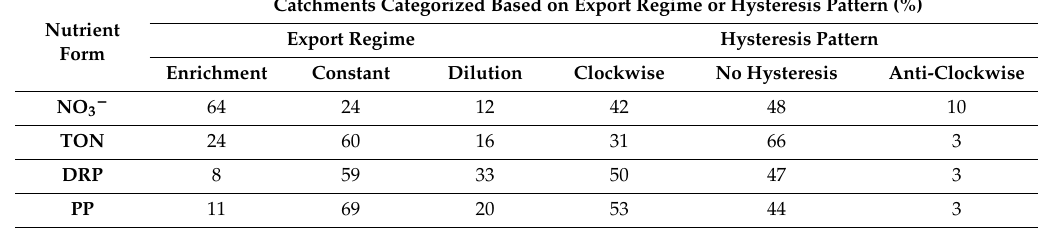
Table 2. Results on the percentage of mini-catchments in three Nordic countries: Denmark, Sweden, and Finland, considering export regime (enrichment, constant, and dilution) and hysteresis patterns (clockwise, anti-clockwise, and no hysteresis) including nitrate (NO 3 − ), total organic N (TON), dissolved reactive P (DRP), and particulate P (PP). Catchments Categorized Based on Export Regime or Hysteresis Pattern (%) Nutrient Export Regime Hysteresis Form